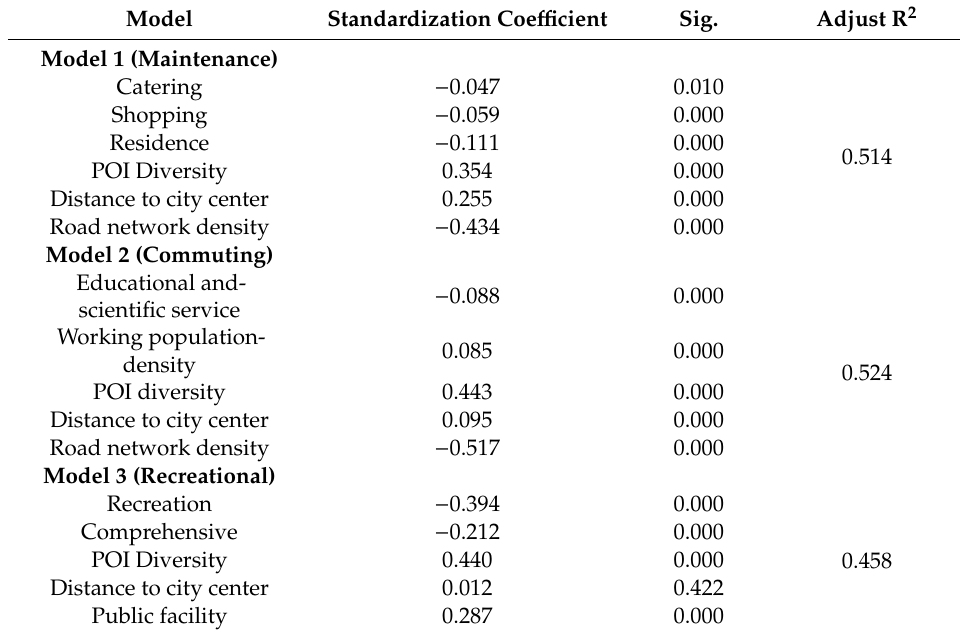
Table 4. Regression results on the relationship between built environment factors and activity space.